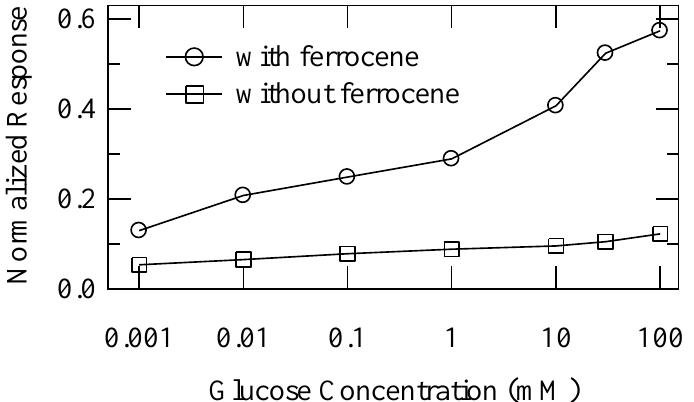
Figure 3 . Normalized response to glucose concentration for OECTs preloaded with a mixture with (open circles) and without (open squares) ferrocene mediator. The lines are guides to the